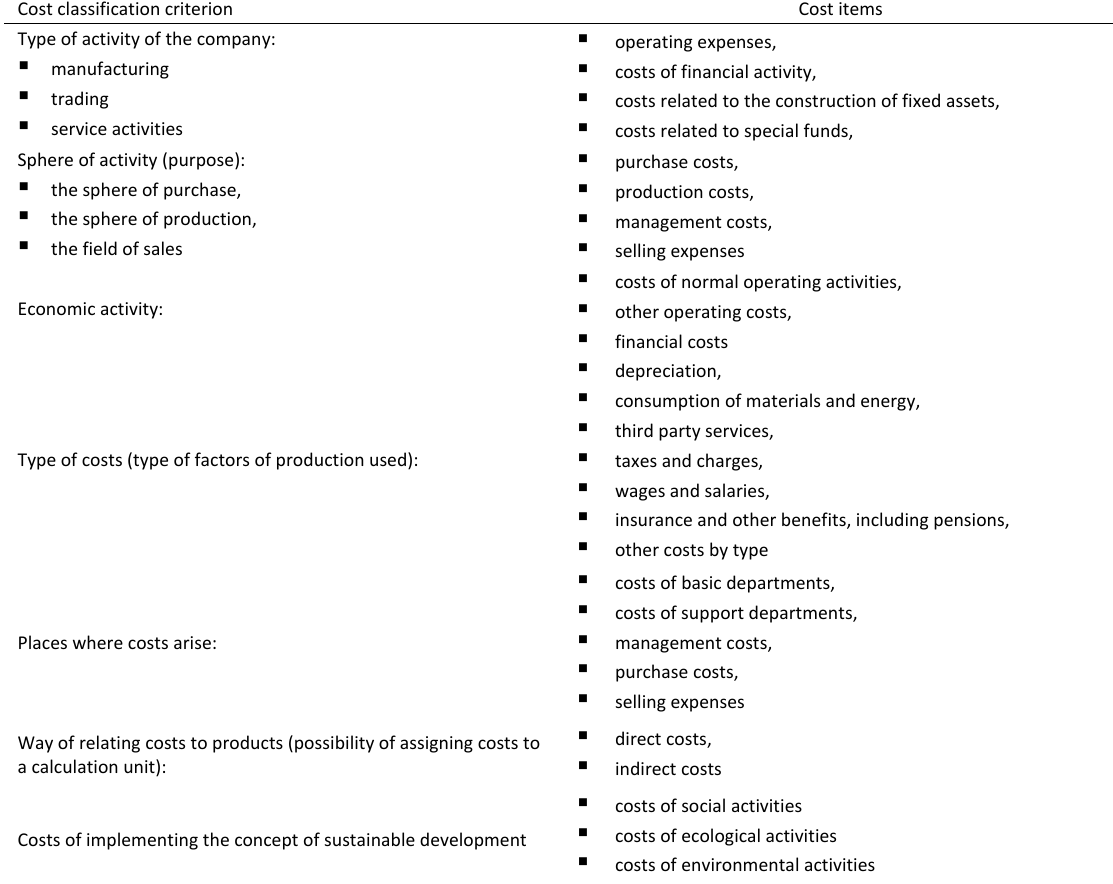
Table 1: Classification of costs for accounting purposes (Czubakowska et al., 2008)